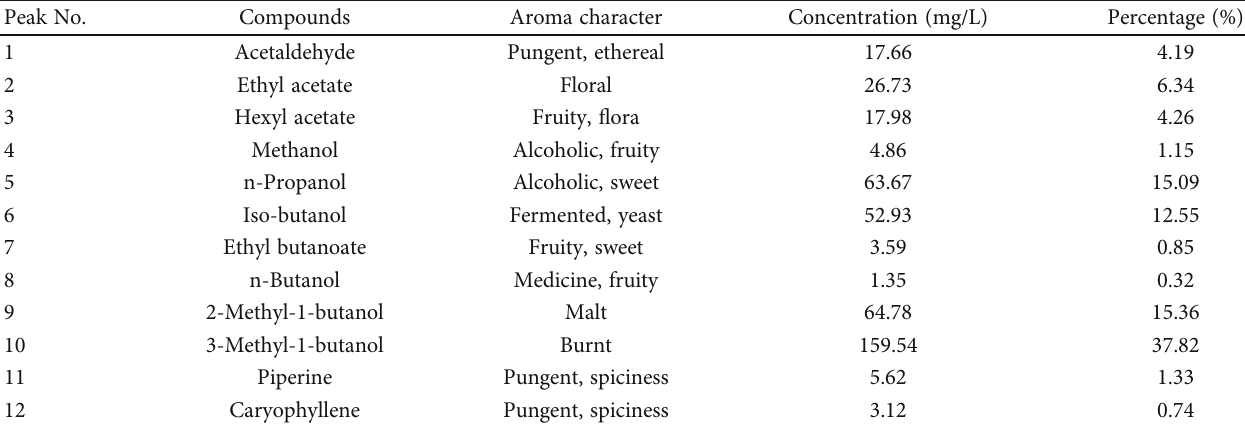
Table 4: Main aroma compounds extracted from pepper whisky.